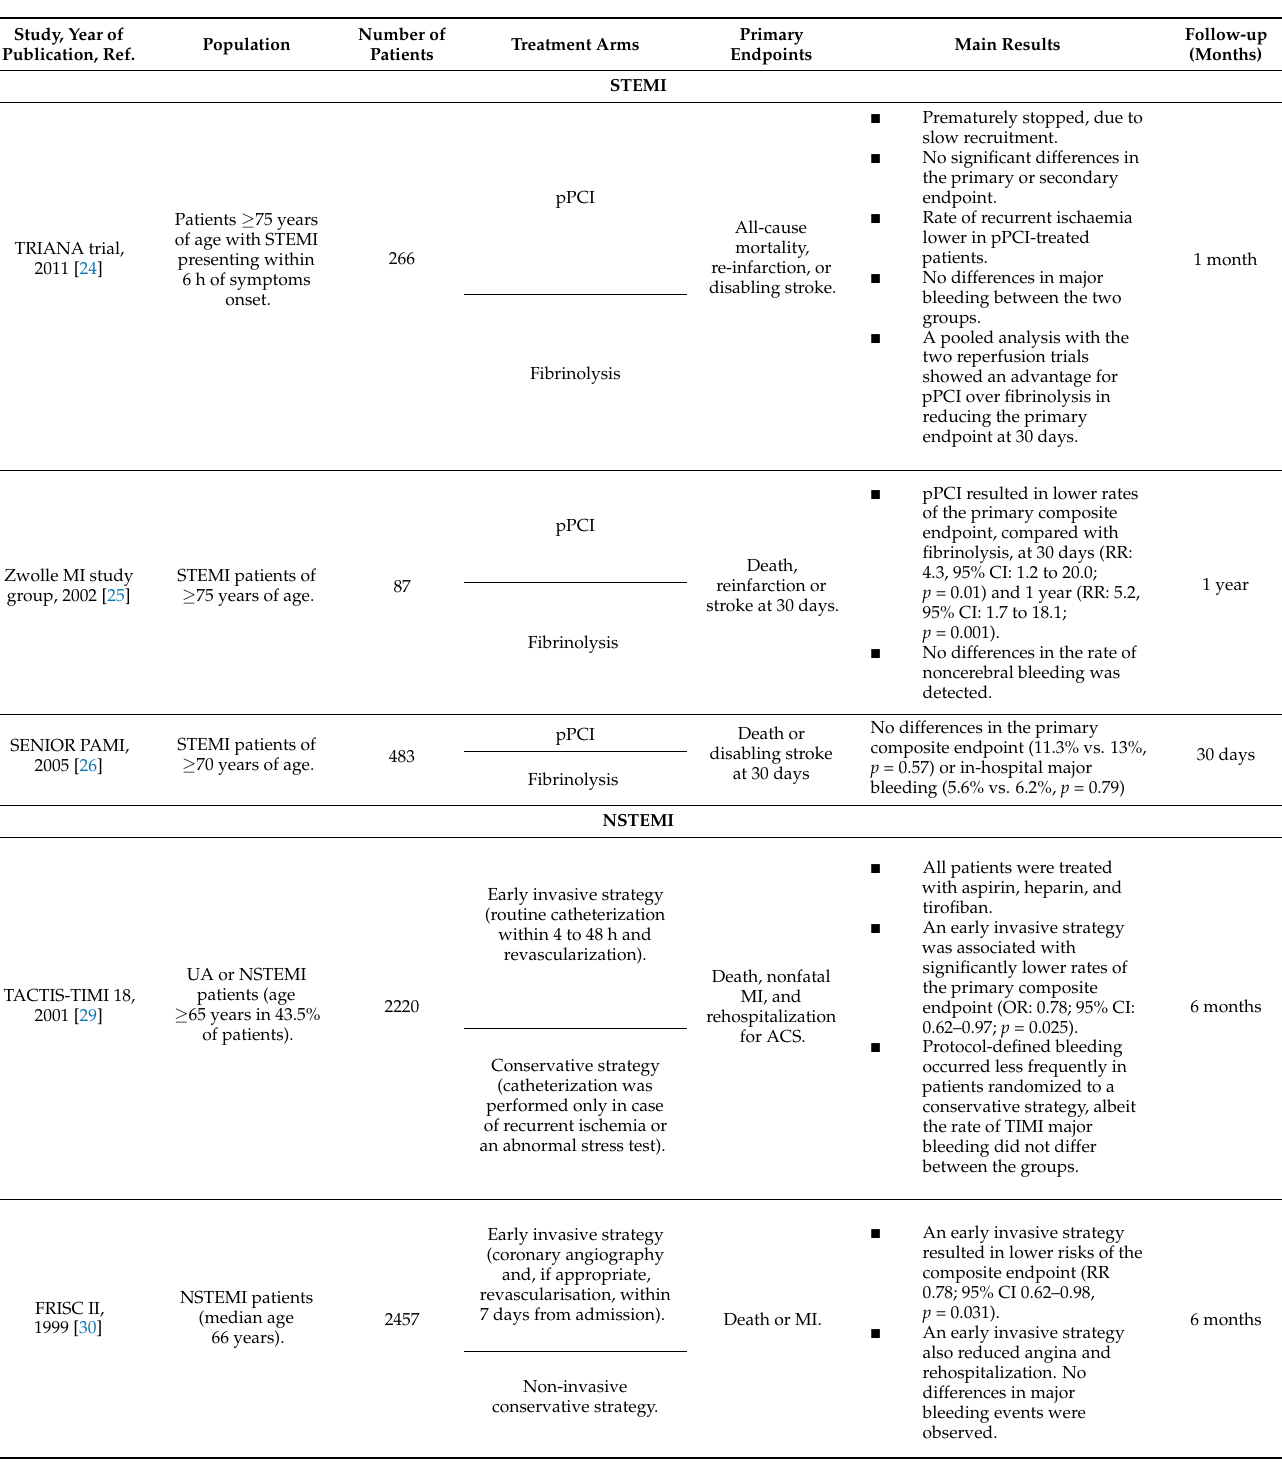
Table 1. Randomized clinical studies comparing invasive versus conservative management of elderly patients admitted for ACS with or without persistent ST-segment